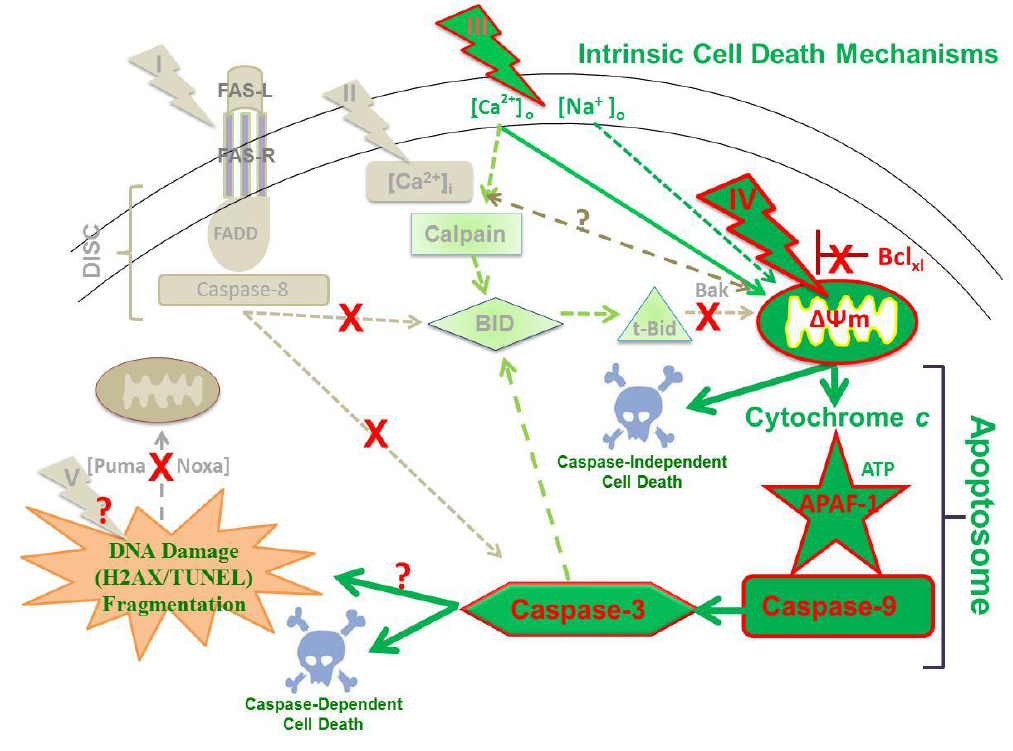
Figure 10. A model for nsPEF-induced cell death in human Jurkat